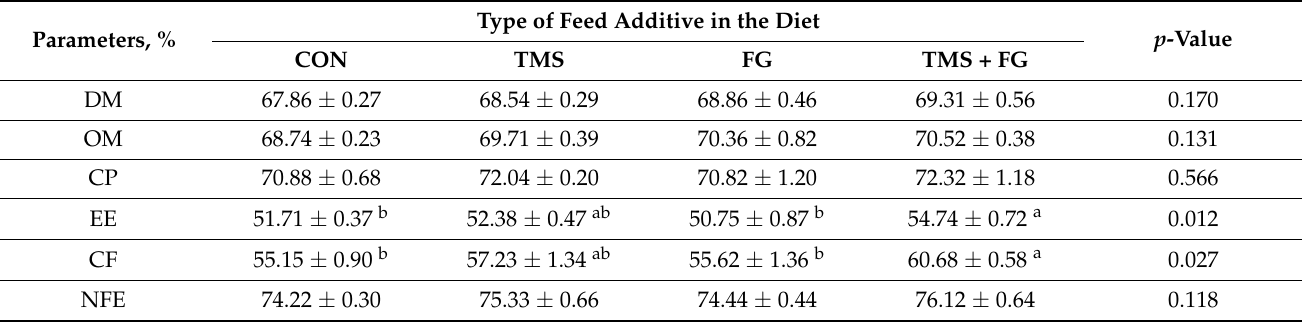
Table 5. Indicators of digestibility of nutrients in lactating dairy